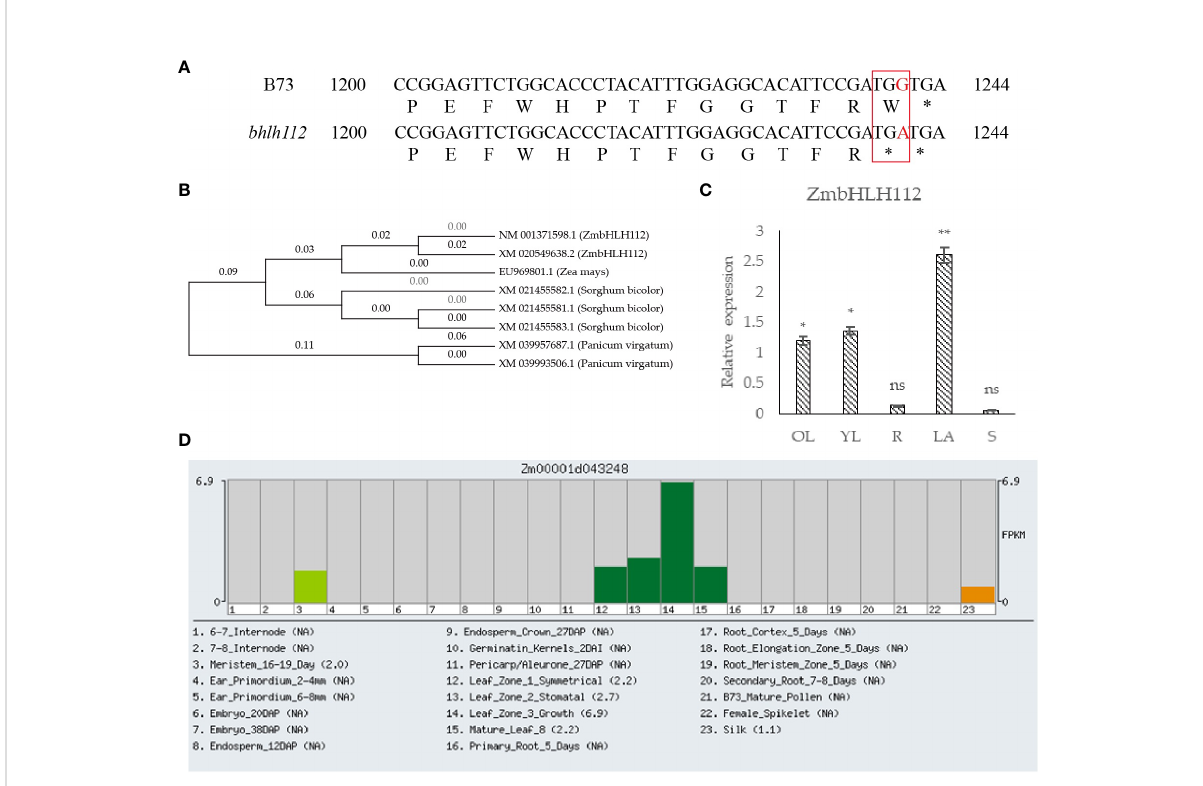
FIGURE 1 Analysis of the ZmbHLH112 gene in maize. (A) Partial sequence alignment of the ZmbHLH112 gene in mutants bhlh112 and B73. (B) Evolutionary tree of the ZmbHLH112 gene. (C) Relative expression of ZmbHLH112 in different tissues. (D) Gene Expression Atlas of the ZmbHLH112 gene from Maize GDB. OL, old leaves; YL, young leaves; R, roots; LA, the leaf occipital part of the second leaf at the V3 stage; S: stems. ** indicates P < 0.01, * indicates P < 0.05. ns indicates not signi fi